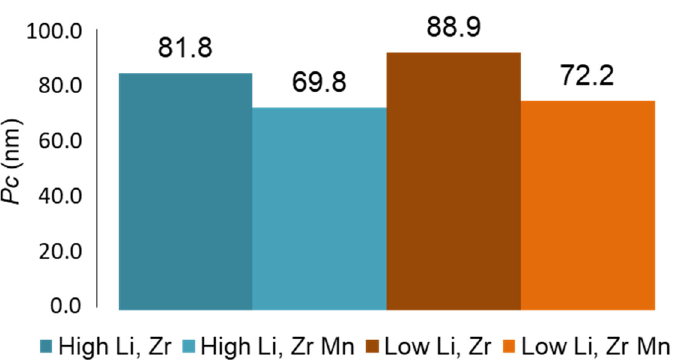
Figure 5. Average slip band extrusion height on slip bands measured for two aluminum alloys with two configurations of dispersoids on brass grains using interferometry.